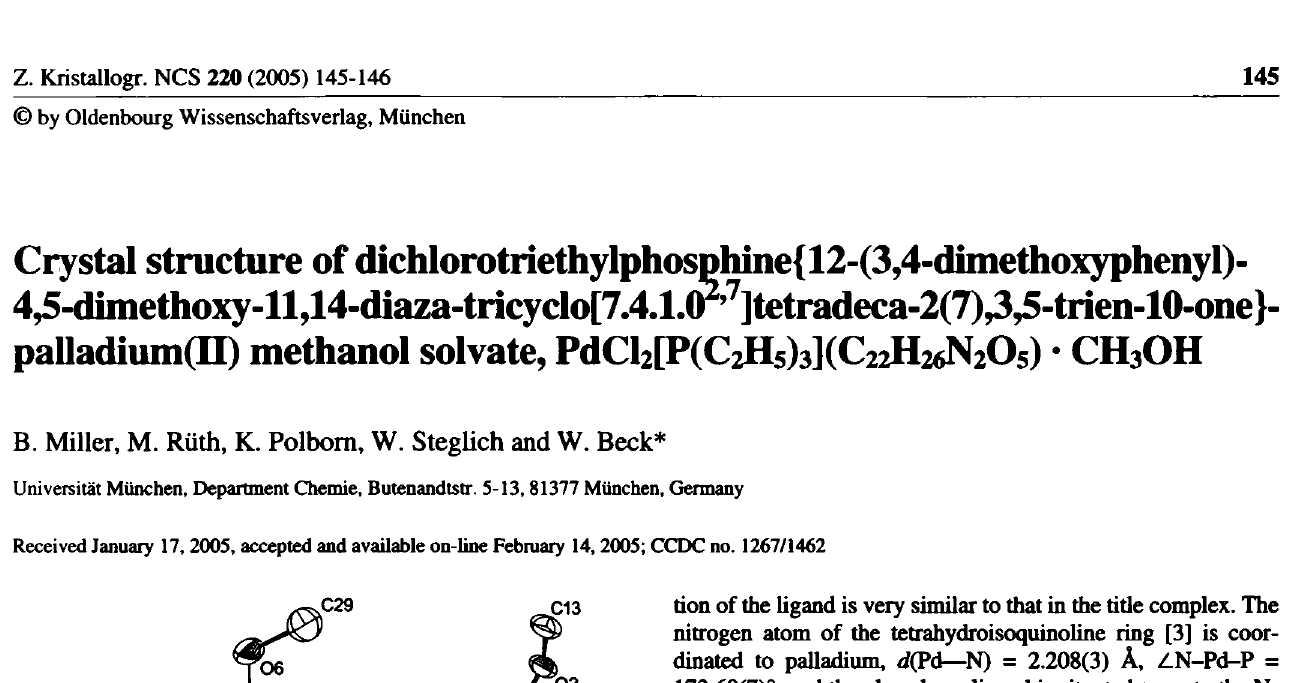
Table 1. Data collection and handling.